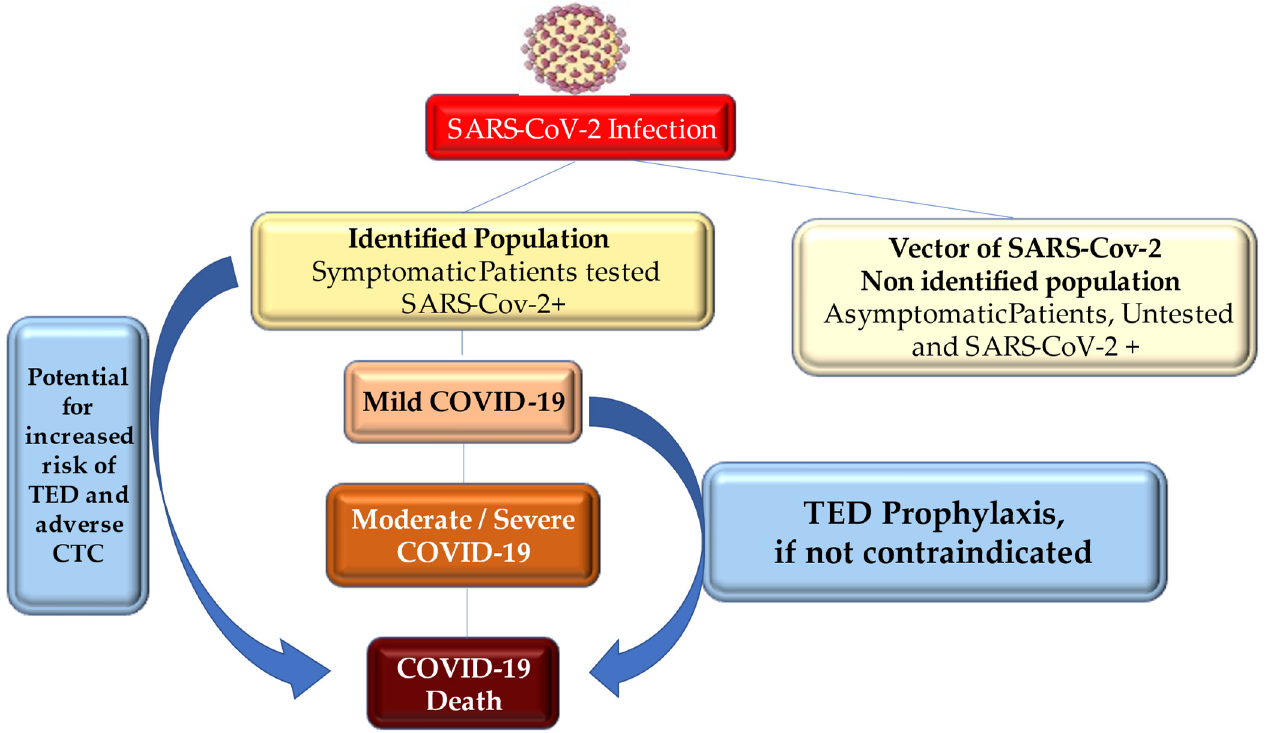
Figure 1. SARS-CoV-2 has spread with dissimilarity rates of the infection among population, and it has been characterized by distinct case fatality rates, across various regions and countries. Inflammatory response, increased age, and bedridden status, which are more frequently observed in severe coronavirus disease 2019 (COVID-19), may contribute to thrombosis and adverse outcomes. Abbreviations: CTC, cardiac thrombotic complication; SARS-CoV-2, severe acute respiratory syndrome-coronavirus-2; TED, thromboembolic disease.